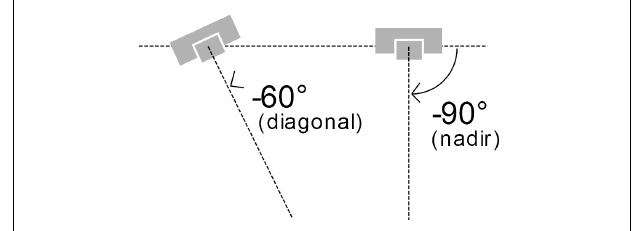
FIGURE 3 | An illustration of the camera angle.